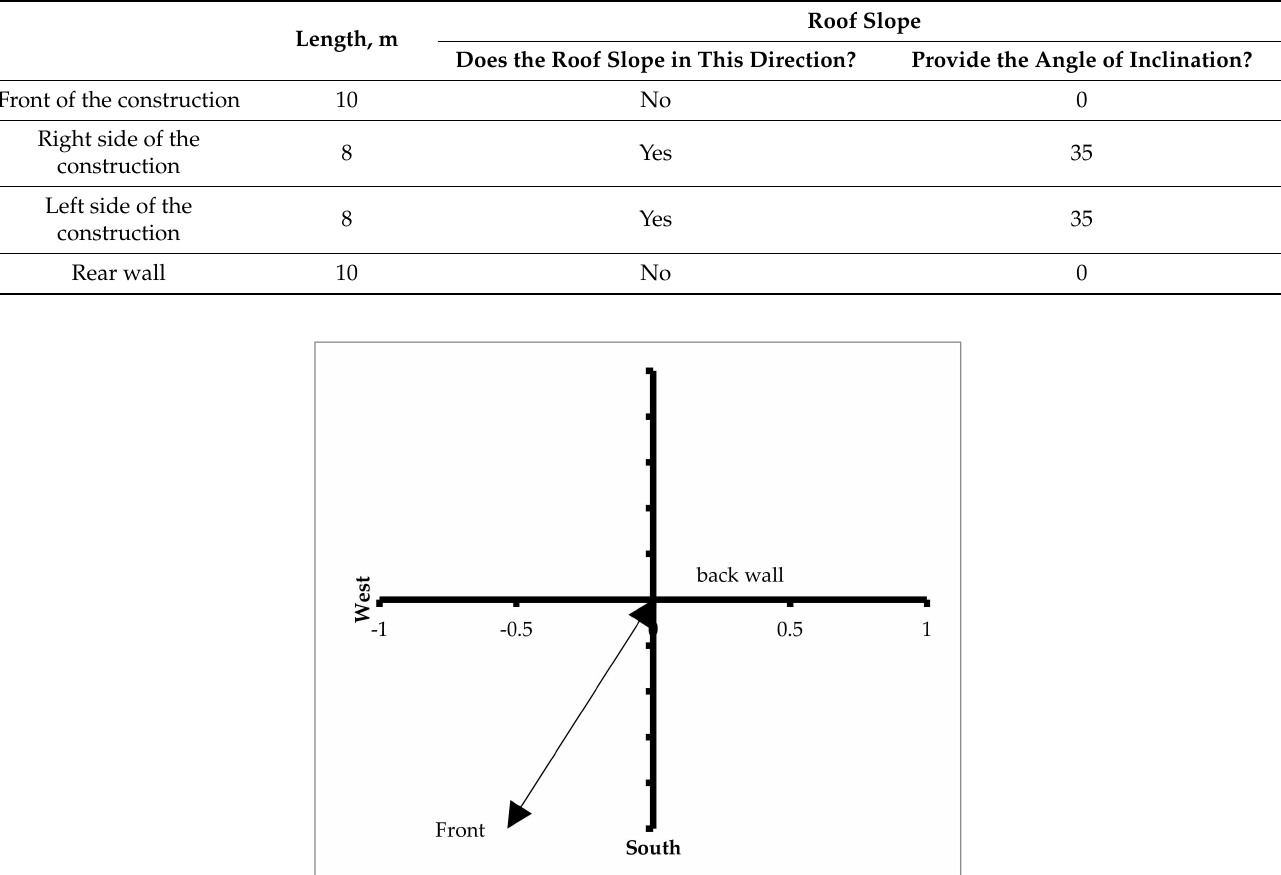
Table 11. Technical data of the planned single-family house in Turawa-Marszalki.